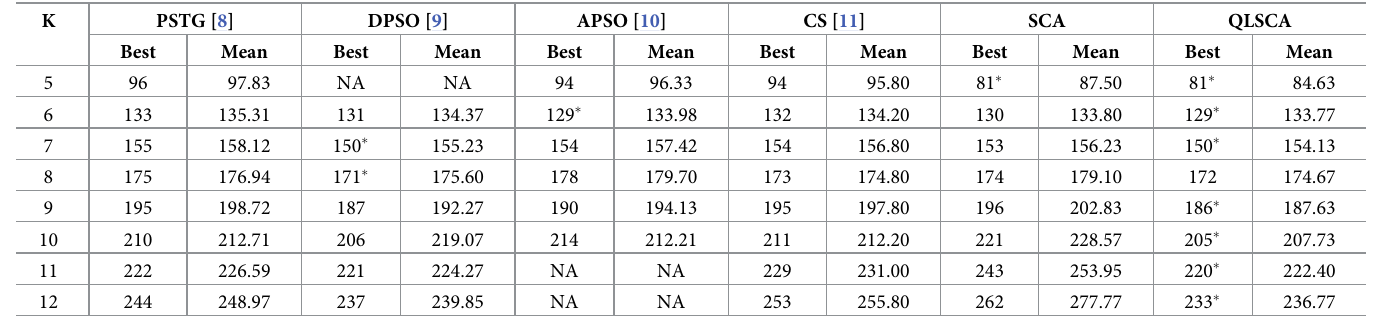
Table 6. Size performance for CA ( N ;4, 3 k ) where k is varied from 5 to 12.